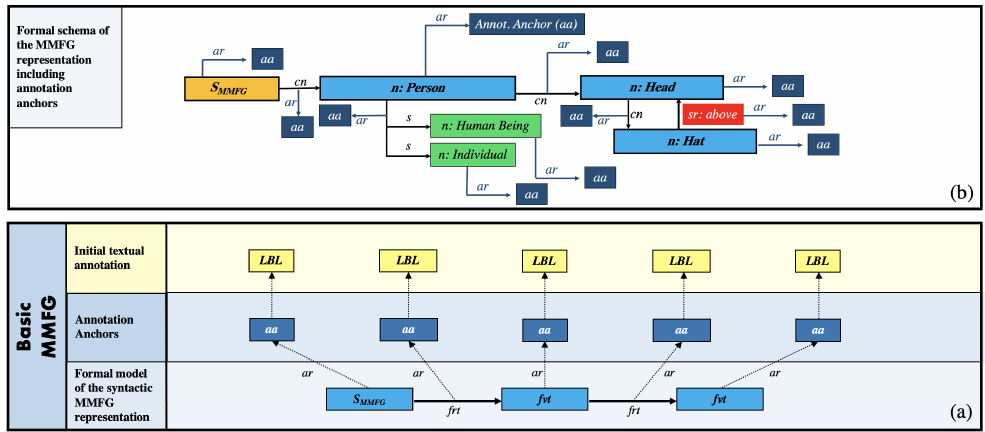
Figure 4. MMFG overview including Annotation Anchors (aa) and Annotation Relationships (ar) : ( a ) formal model; ( b ) formal syntactic schema of the MMFG representation MMFG ex